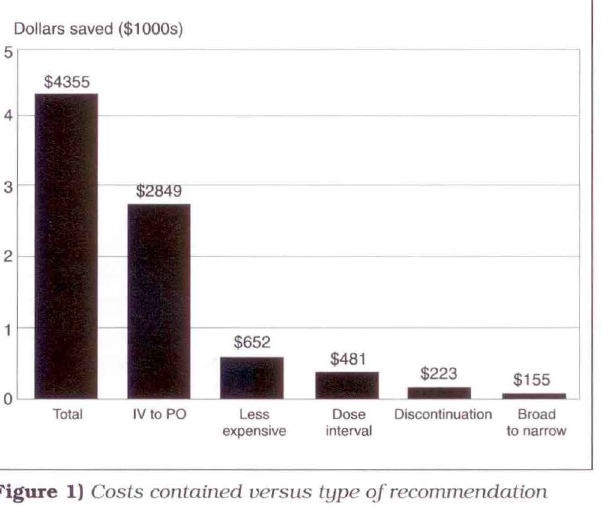
Reasons for noncompliance with recommended